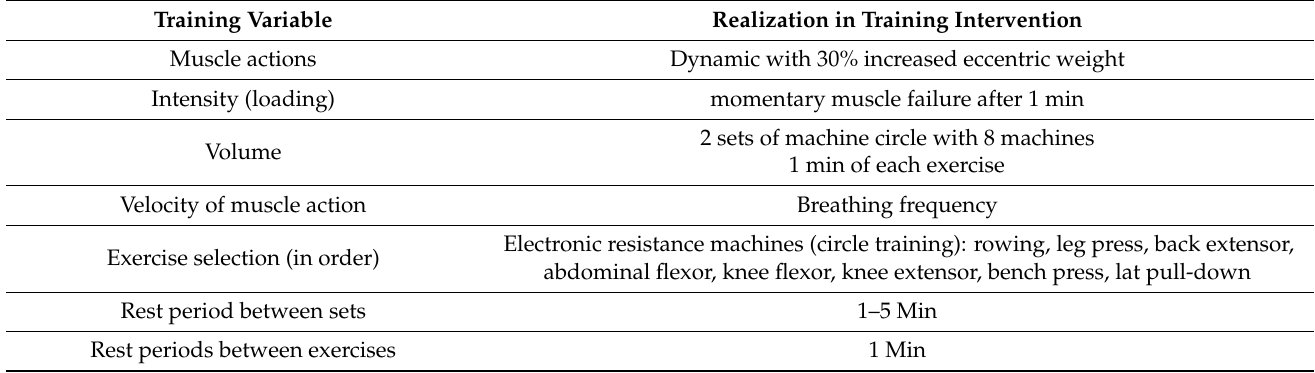
Table 1. Definition of training variables.